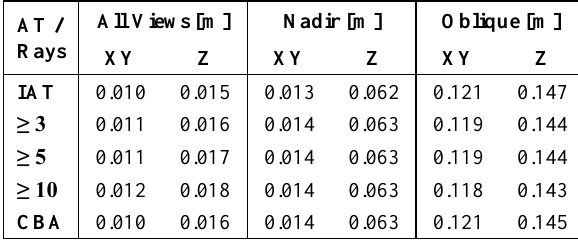
Table 1. Check point standard deviations (RMS values) for dif- ferent AT approaches, integrated (IAT) vs. hierarchical.